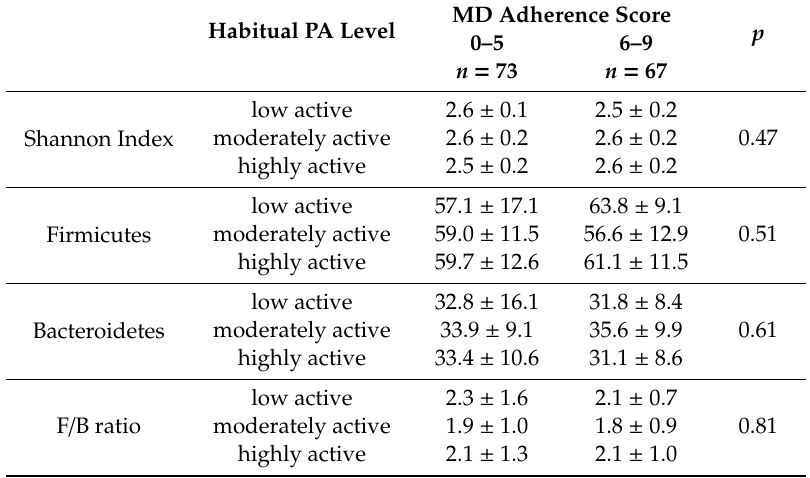
Table 3. Comparisons of the Shannon Index, Firmicutes , Bacteroidetes , and F/B ratio of the subgroups categorized on the basis of MD adherence and PA levels, with corresponding p -values.